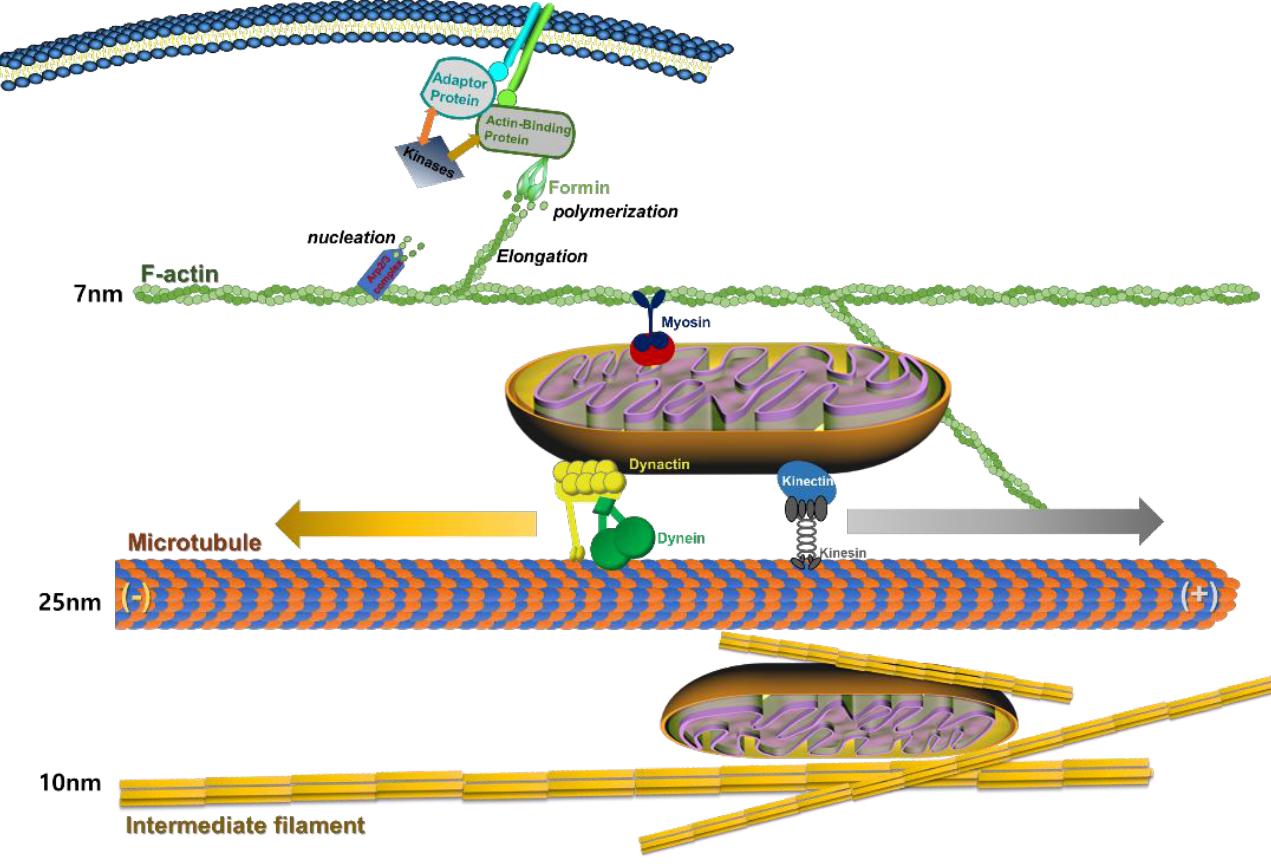
Figure 1. The structural property and modulation of actin-cytoskeleton and mitochondria transfer .